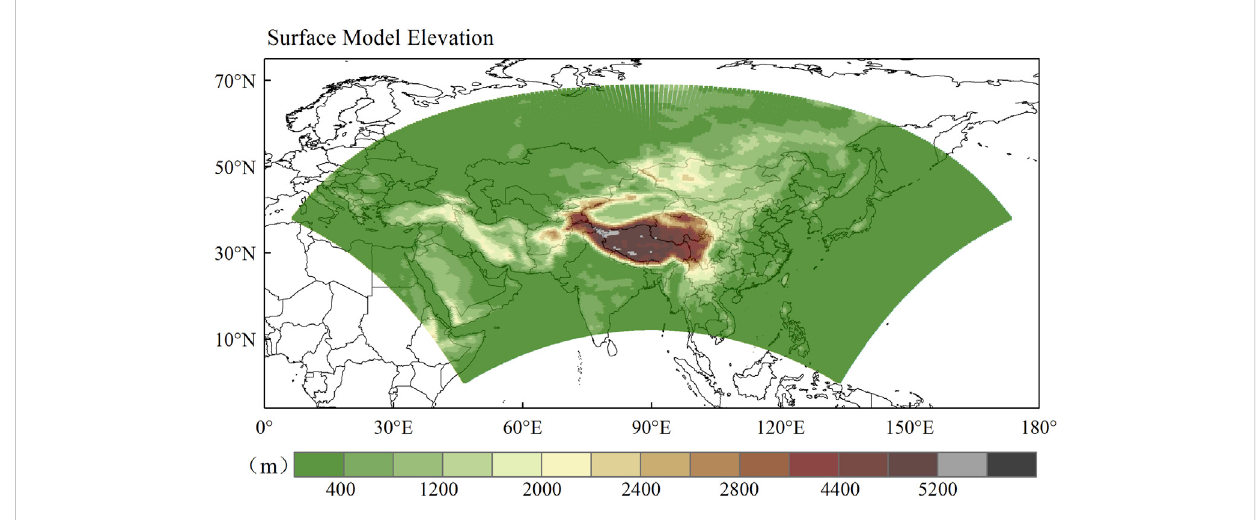
FIGURE 3 Simulation area and its terrain distribution (unit of altitude: m).